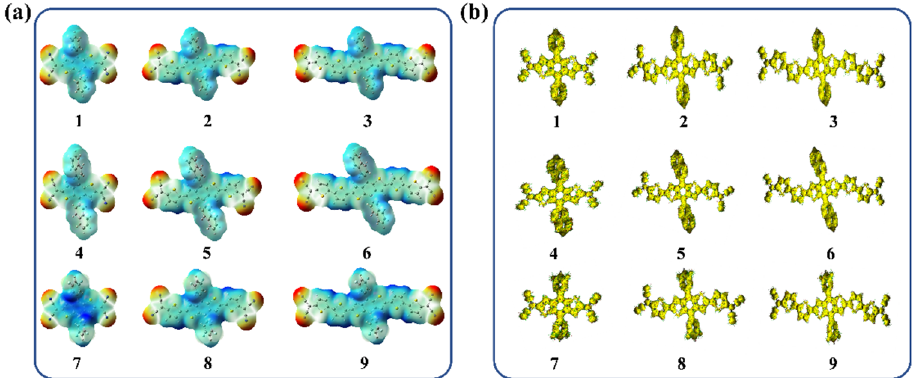
Figure 7. ( a ) The molecular surface electrostatic potentials of all the compounds (1 − 9), red and blue, represent the negative and positive potential, respectively; ( b ) AICD plots (isovalue: 0.03 a.u.) of the compounds (1 − 9).